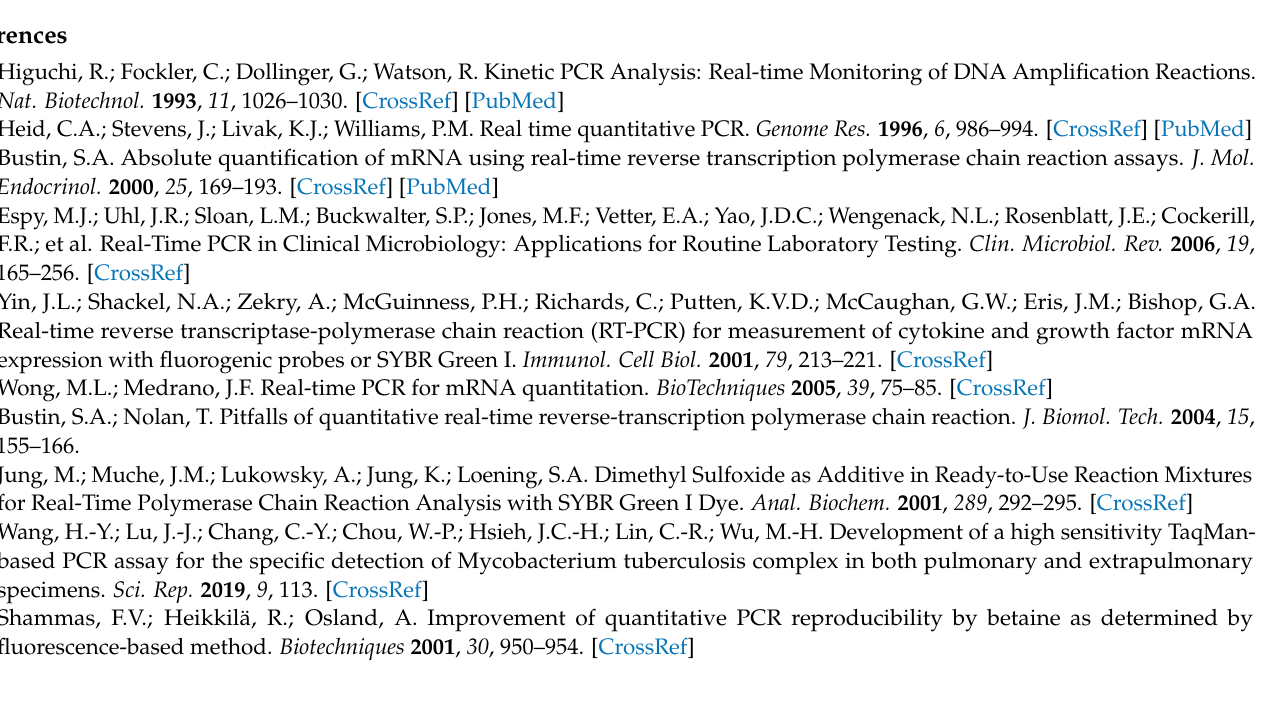
Figure S1: Real-time fluorescence monitoring of target RNA (IFZ B) amplification with GO and nGO; Figure S2: Real-time fluorescence monitoring of qPCR-amplified products with serially diluted (188 ng to 0.37 ng) target (IFZ B) RNA in the absence of PEG-nGO and in the presence of PEG-nGO; Figure S3: Analysis of qPCR-amplified products with non-target (IFZ A) RNA in the presence or absence of